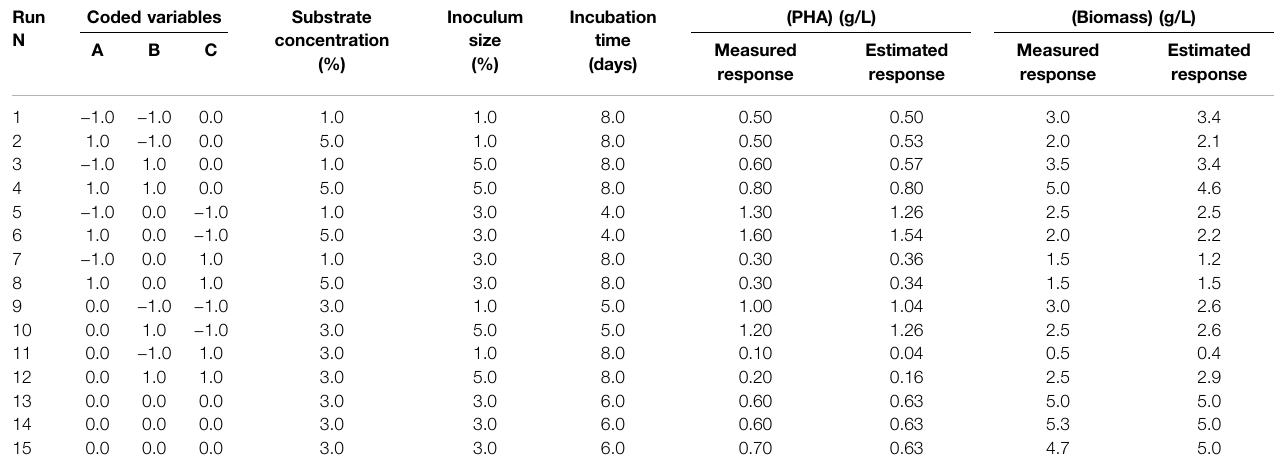
TABLE 1 | Experimental conditions of BDD in natural variables and the corresponding experimental and theoretical PHA production responses. Run Coded N